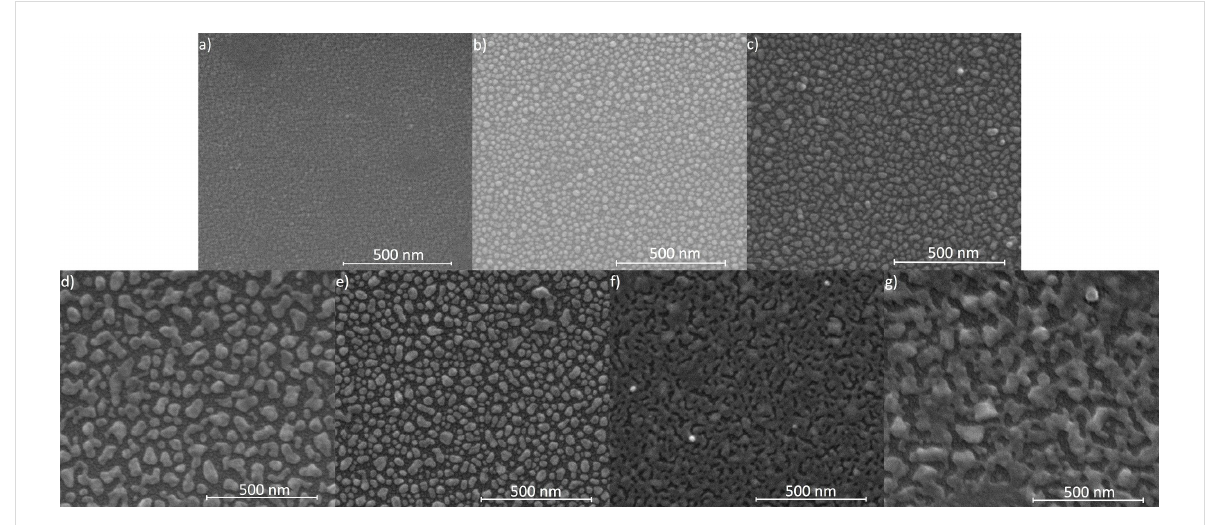
Figure 3: SEM images of the films after annealing at 250 °C for 15 min. Initial film thickness was: (a) 1 nm, (b) 2 nm, (c) 3 nm, (d) 4 nm, (e) 5 nm, (f) 6 nm and (g) 7 nm.